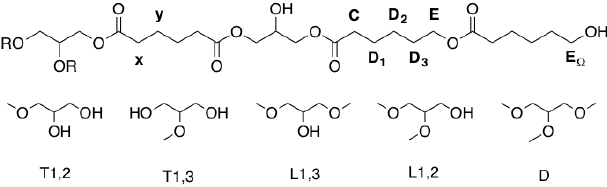
Figure A3. Labelling of atoms and structural units of hPES-OCL 9 -OH 3 used for NMR description.